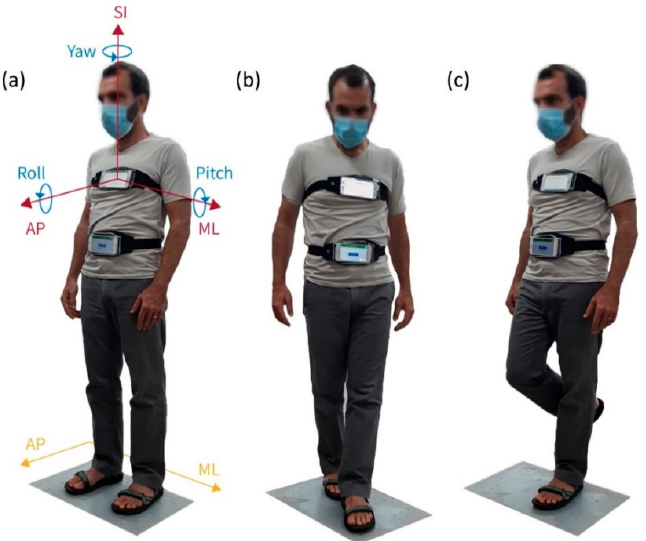
Figure 1. Subject standing on the force plate (FP) wearing two smartphones, one on the sternum and another on the abdomen, with straps, in three standing postures: ( a ) neutral stance (NS)—standing with spread legs; ( b ) tandem stance (TS)—standing with the heel of one foot against the toes of the other foot; ( c ) one-leg stance (OLS)—standing with one leg on the ground. The axis systems of the FP (yellow) and of the smartphones (red) are described in ( a ).